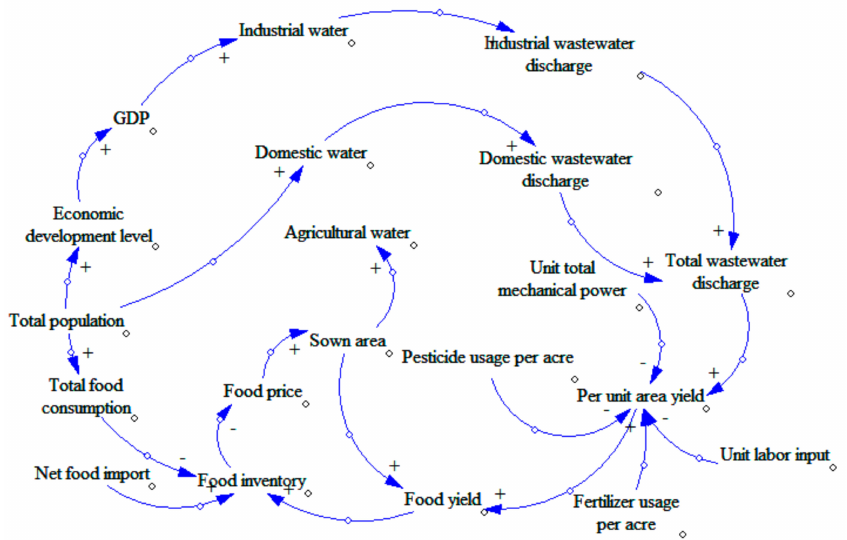
Figure 1. Causality diagram of China’s water subsystem.